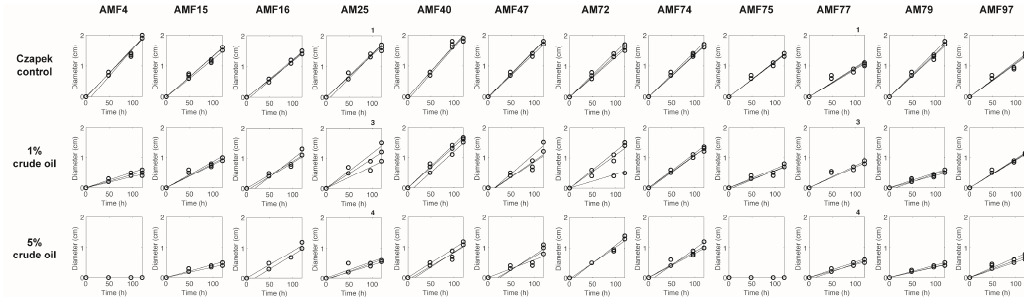
Figure 2 Figure 2. Growth capabilities of the 12 most promising fungal isolates with 1% and 5%